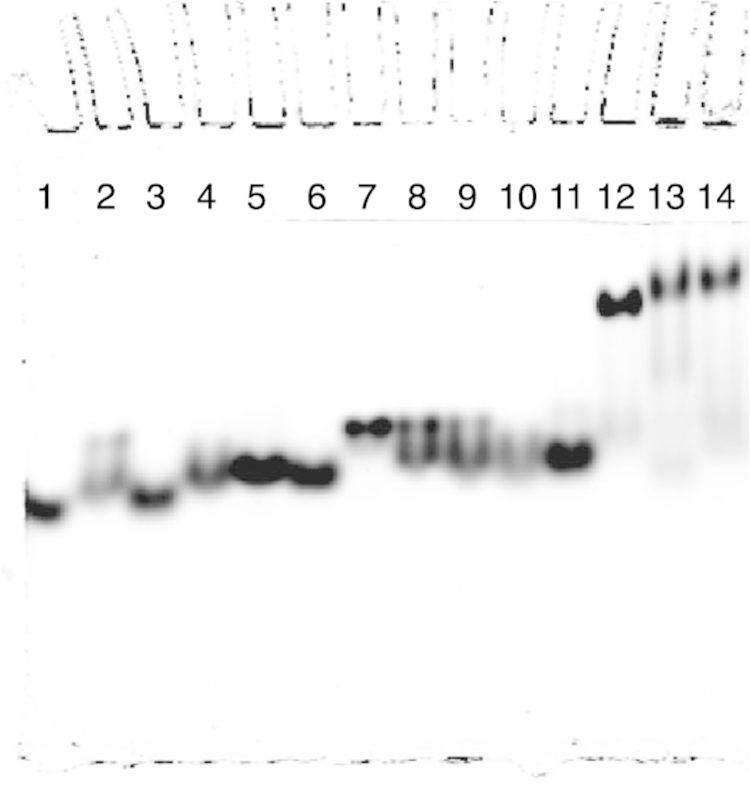
Comparison of multi-DNAs vs. J1, 4WJ:PNA1,3 and b4WJ:PNA1,3.